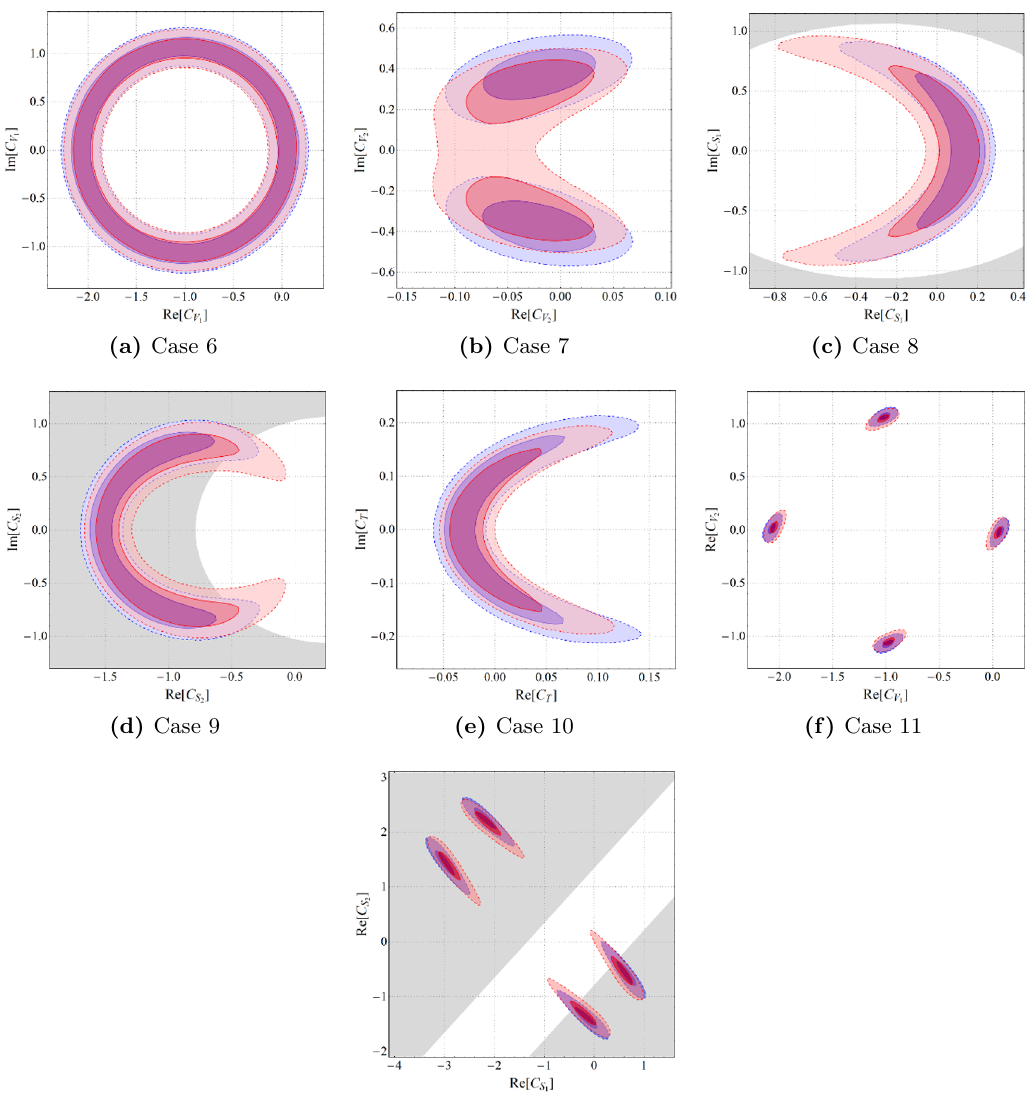
Figure 5. 2D marginal posterior distributions for two parameter NP scenarios in tables 8 and 9. Blue shaded regions correspond to the NP (cid:12)ts to all the experimental inputs in table 7 while the red shaded regions correspond to the (cid:12)ts with BaBar data dropped. Solid and dashed contours enclose respectively 68% and 95% highest probability regions for (cid:12)gures 5a{5e, and 1 and 4 (cid:27) CLs for (cid:12)gures 5f and 5g. The gray shaded regions denote the NP parameter space disallowed by B ( B c ! (cid:28)(cid:23) (cid:28) ) > 30%.